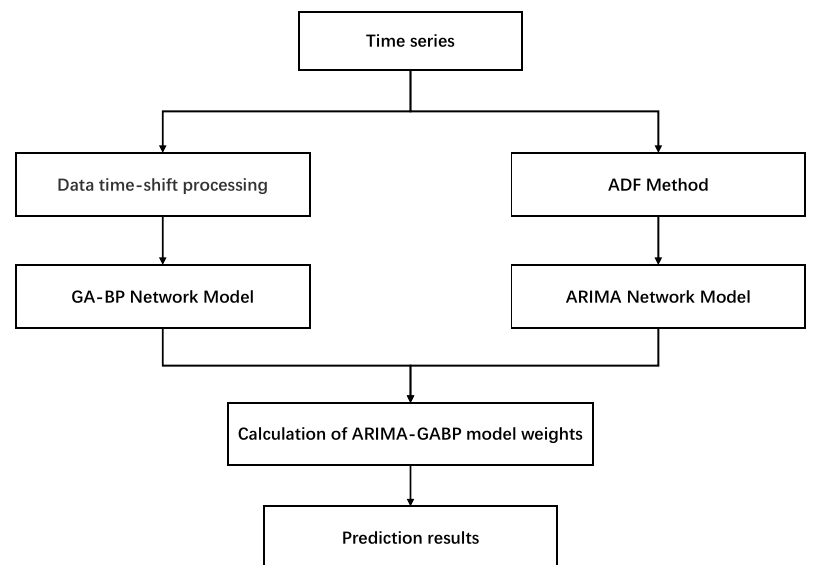
Figure 4. The flowchart of the hybrid ARIMA-genetic algorithm BP (GABP)